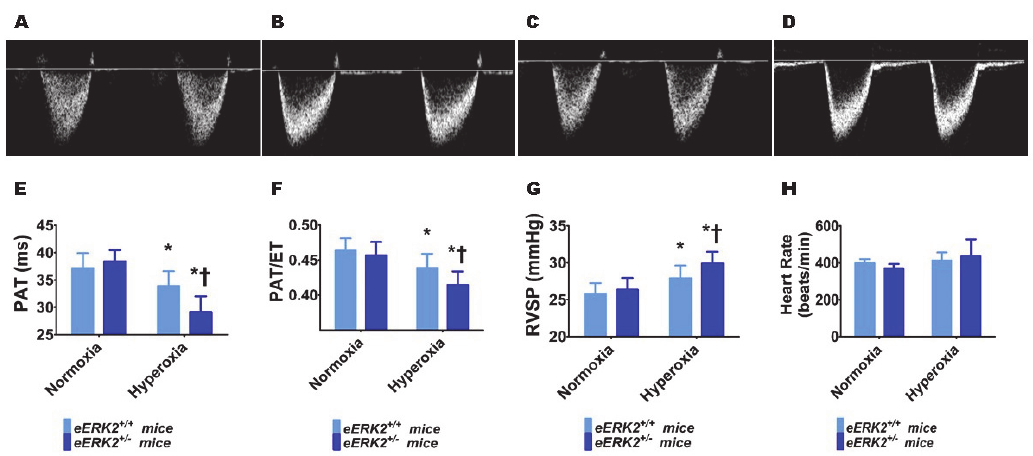
Figure 5. Indices of PH in endothelial ERK2 -su ffi cient ( eERK2 +/+ ) or –deficient ( eERK2 +/ − ) mice exposed to hyperoxia. One-day-old eERK2 +/+ or eERK2 +/ − mice were exposed to either 21% O 2 (normoxia) or